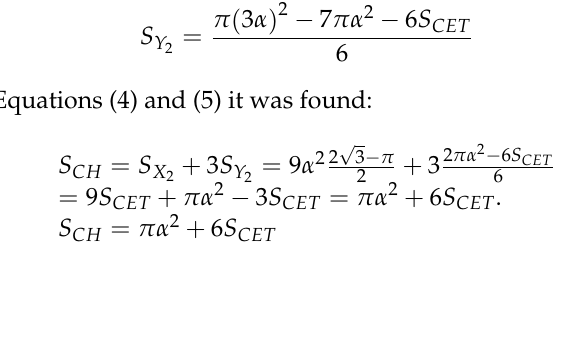
The area of the curved isosceles triangle Y 2 is equal to 1/6 of the difference in the area of the circle of radius 3 α , circumscribed around the Jullien unit formed after the first iteration and the sum of the areas of seven identical spherical particles of radius α 7 α 2 and the six pores of the Jullien unit after the first iteration: Then from Equations (4) and (5) it was